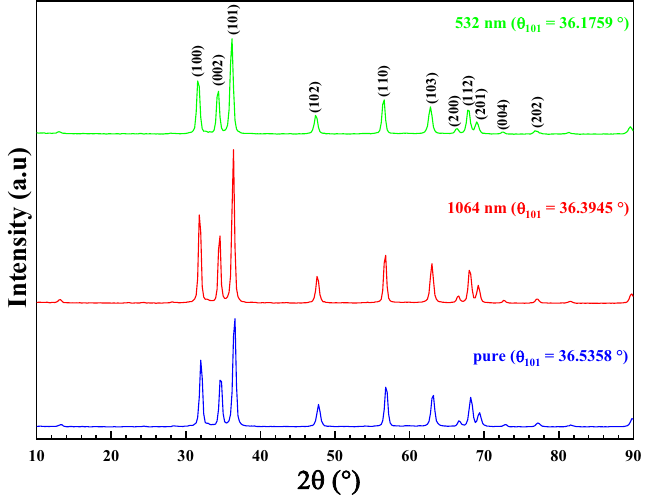
Figure 1. The XRD patterns before and after irradiation with laser beams for ZnO